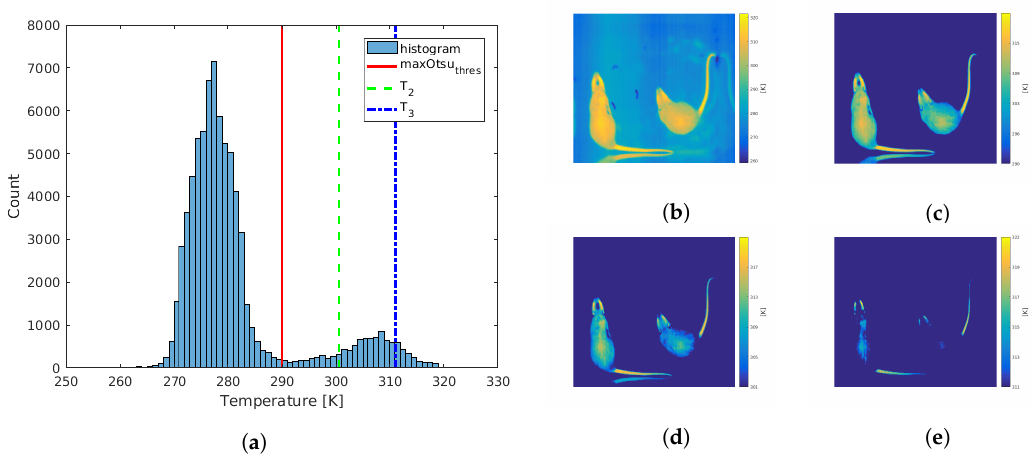
Figure 2. Range selection: ( a ) histogram of one frame raw thermal data with values of: minimal rodent’s surface thermal value named maxOtsu thres , marked with red solid line; the minimum values for images ch2 and ch3 marked as green ( T 2 ) and blue ( T 3 ) lines respectively, ( b ) orig image of the whole thermal range, ( c ) ch1 image of the first range: maxOtsu thres to T max , ( d ) ch2 image of the second range: T 2 to T max , ( e ) ch3 image of the third range: T 3 to T max